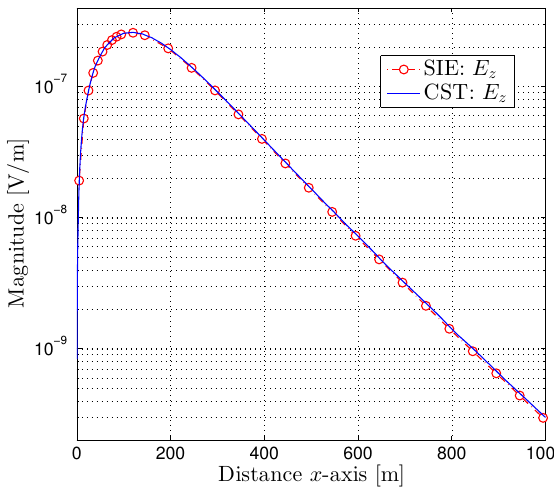
Figure 7. Electric field in the z -direction component at test point ( x ,0, − 500 )